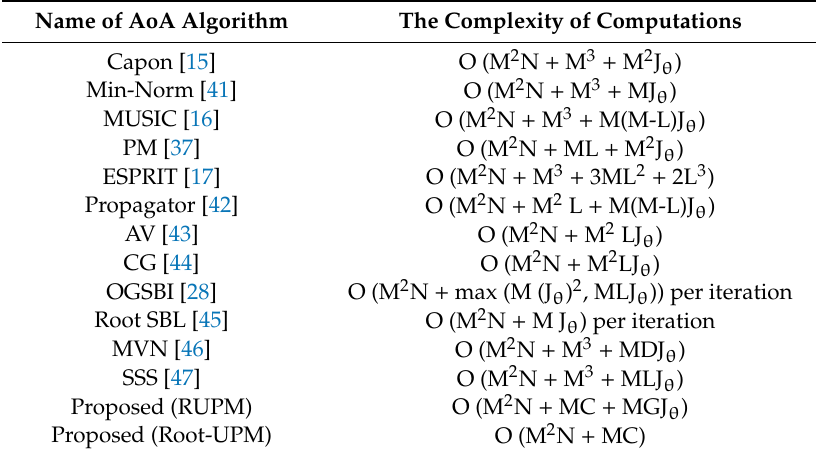
Table 1. The required number of computational operations